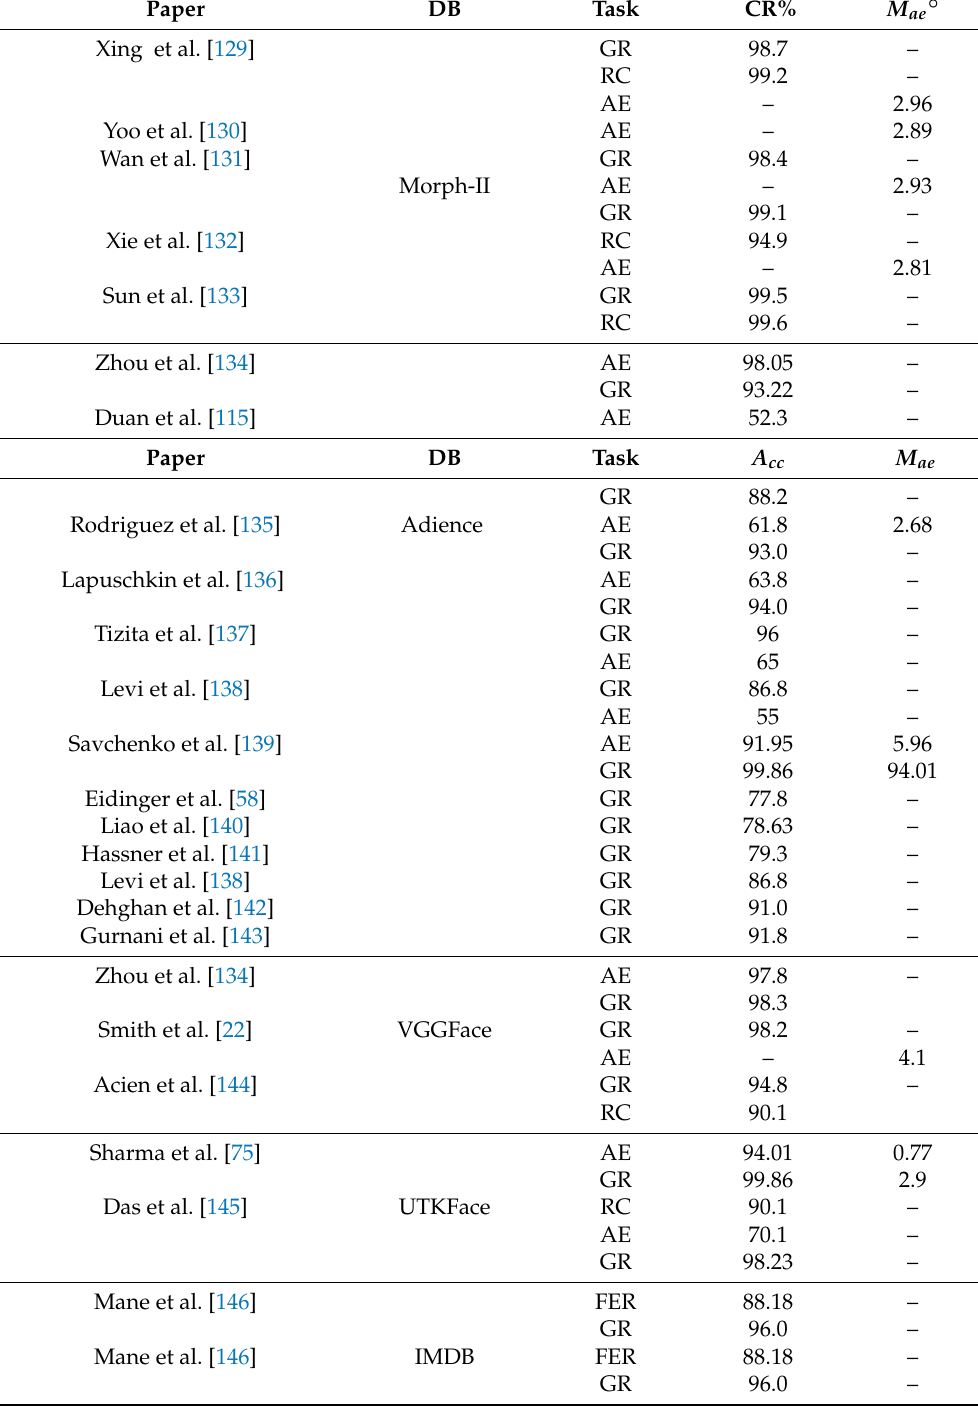
Table 2. Performance comparison of various algorithms for age estimation (AE), gender recognition (GR), race classification (RC), facial expression recognition (FER), and head pose estimation